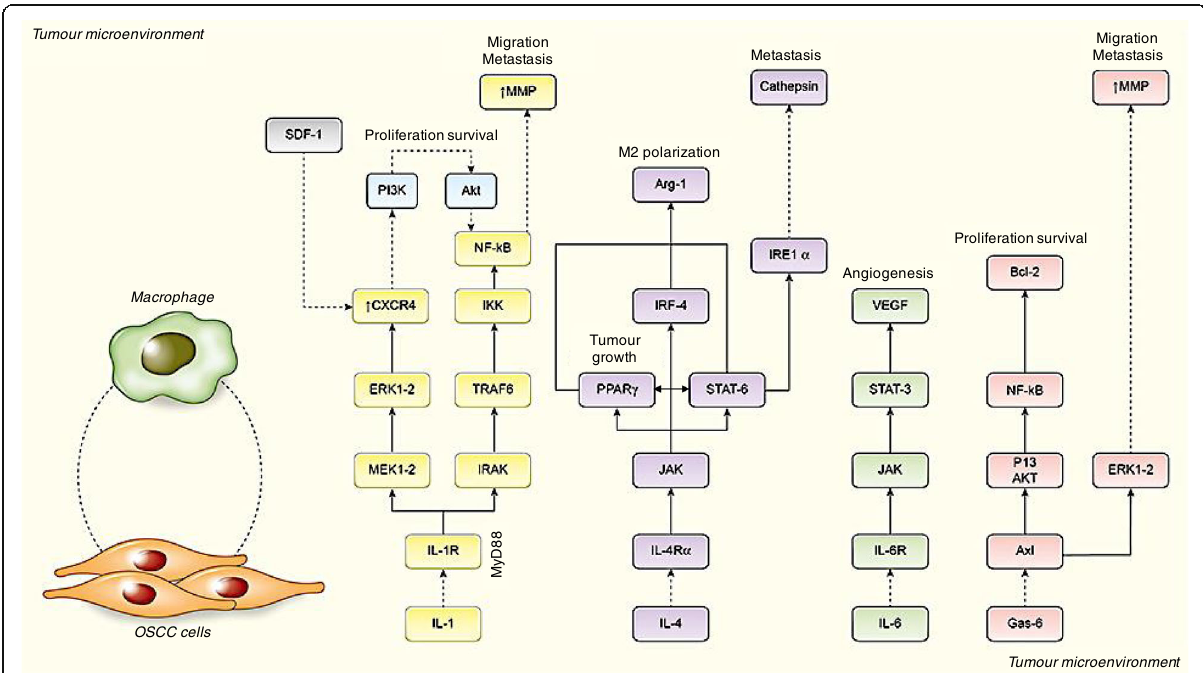
Fig. 1 Macrophages in resting state suffer microenvironmental effects coordinated by OSCC cells. Interleukin (IL)-1, IL-4, IL-6, IL-8 and IL-10 (not shown), and Gas-6 are produced by OSCC cells and promote macrophage phenotype switching to an M2 polarization state. In turn, TAMs augment the recruitment of chemotactic receptors to tumour sites, induce tumour proliferation, and favour angiogenesis and